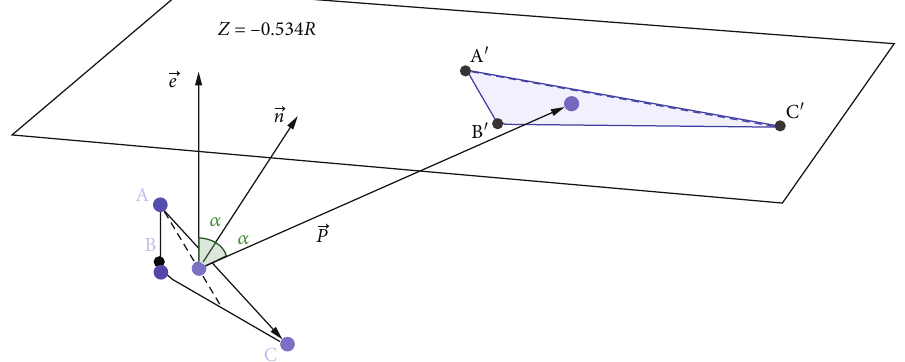
Figure 6: Projection diagram of the triangular re fl ection